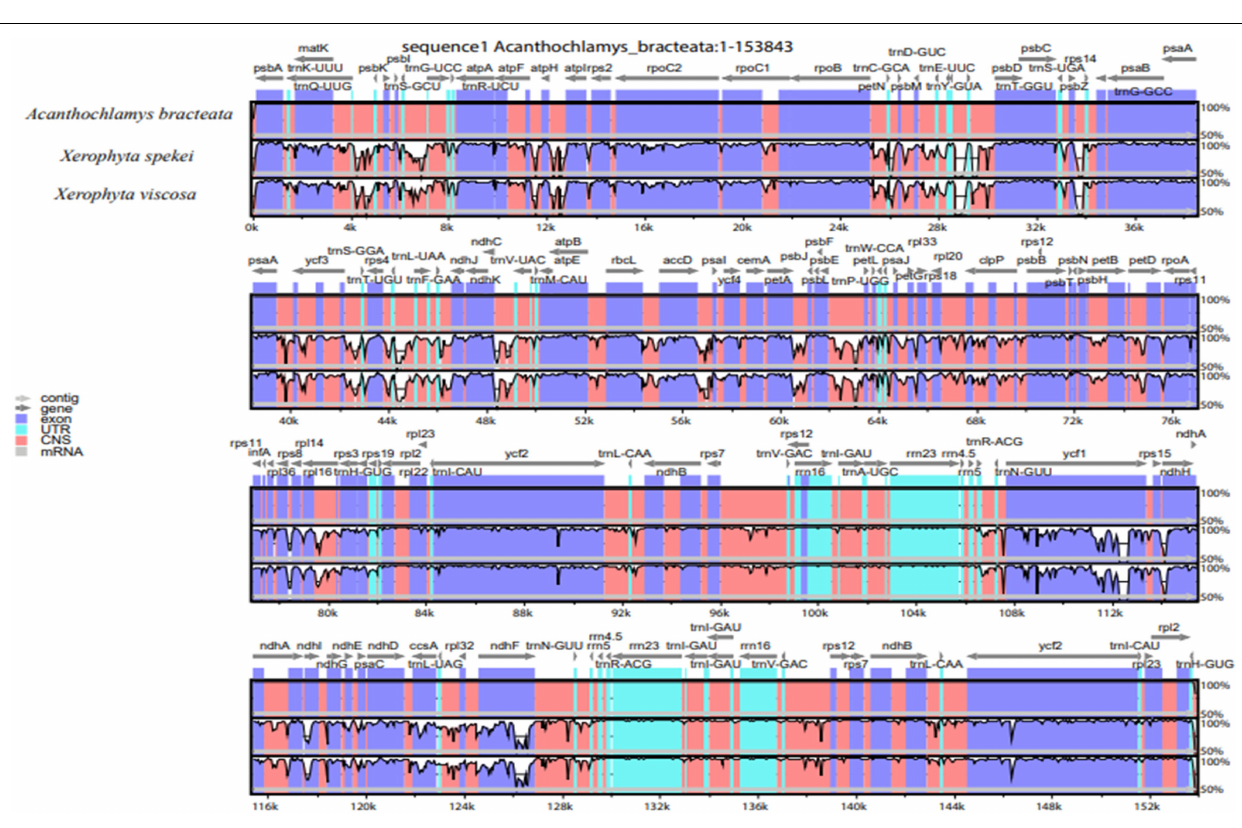
FIGURE 9 | DNA sequence comparison of the three chloroplast genomes using mVISTA program. Above gray lines show the gene orientation and the position in the LSC, SSC, and IRs regions. The vertical scale indicates the percentage of identity of